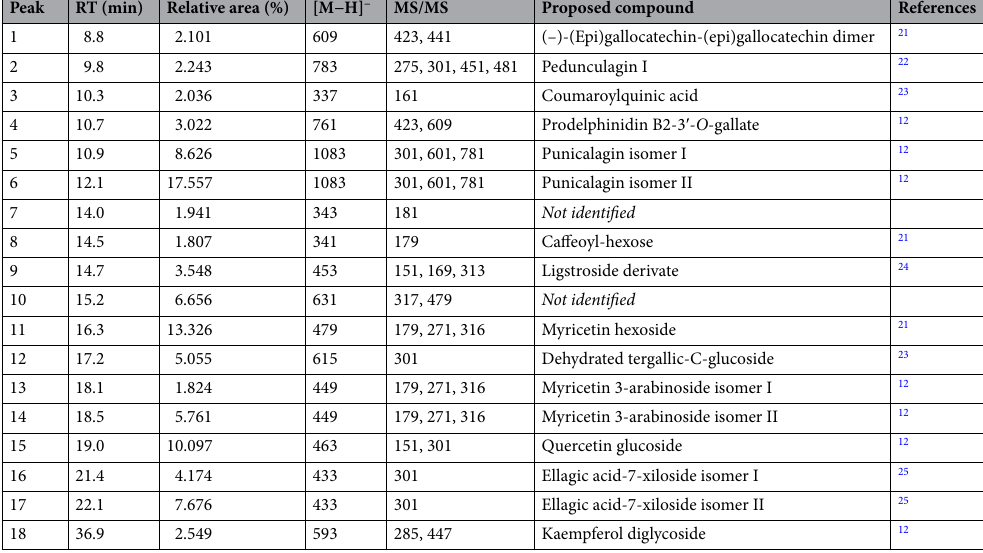
Table 2. Identified compounds in the CS extract using HPLC–MS.